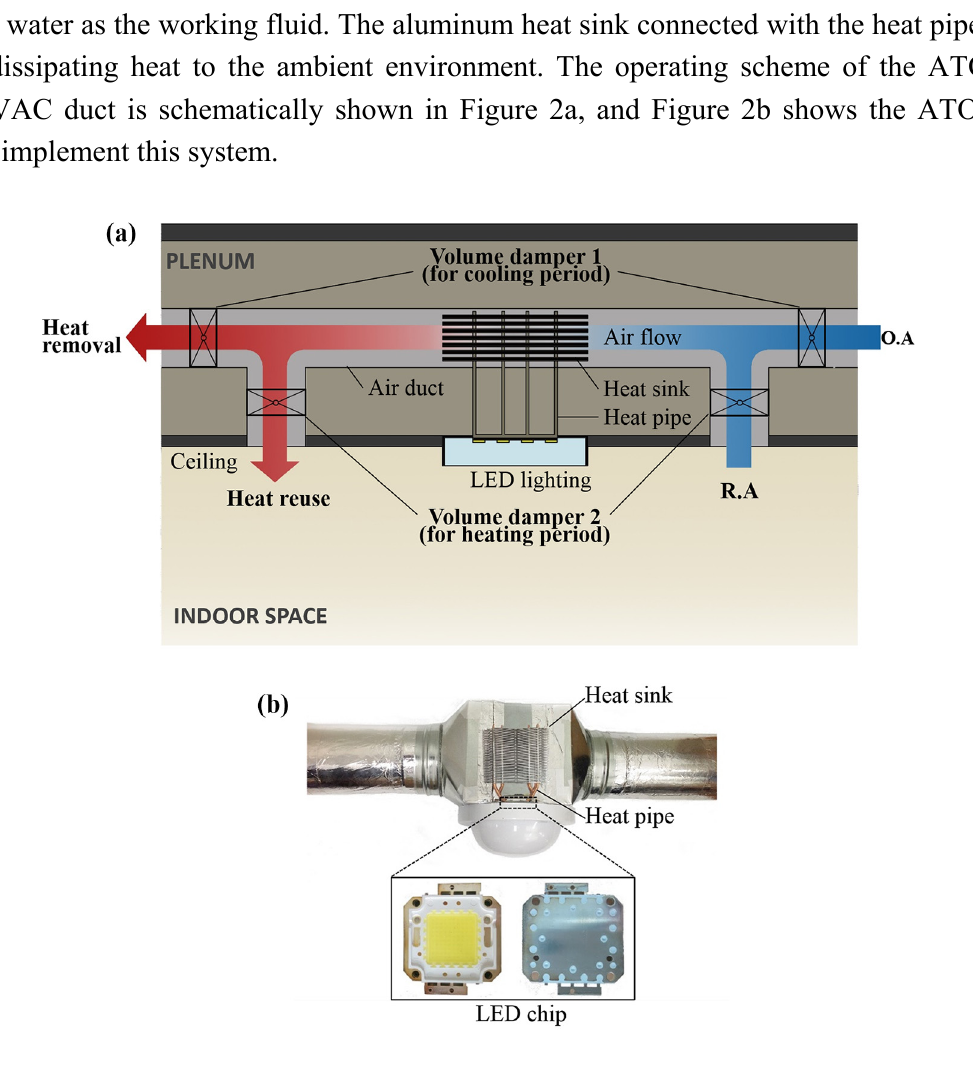
Figure 2. ( a ) Operating scheme of the ATOS with a building HVAC duct and ( b ) A photograph of the ATOS